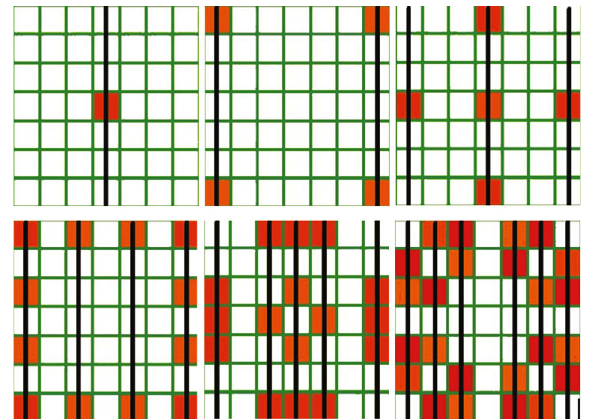
k = 1 :: 6 de fi ned by the number of segments (black lines) that a ff ect those clusters (orange cubies are father Figure 5: Six types of clusters C k away in this projection).